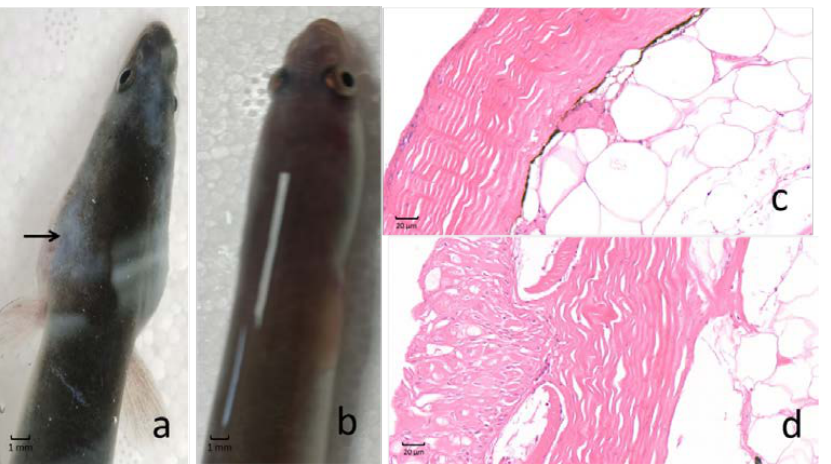
Figure 1. The morphological and histopathological changes observed in the skin in AngHV-infected A. anguilla . The morphological image for the eel infected by AngHV ( a ) and the healthy eel ( b ) showed that the skin mucus was sloughed. The histopathological images for the AngHV group ( c ) and the control group ( d ) show that the skin had exfoliation of mucus and mucosa flat epithelial cells in the eel infected by AngHV.